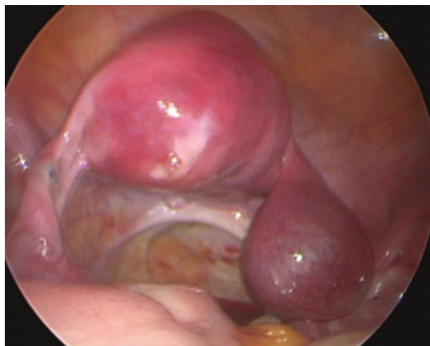
Figure 4: Direct visualization of ectopic pregnancy in right rudi- mentary horn with left unicornuate